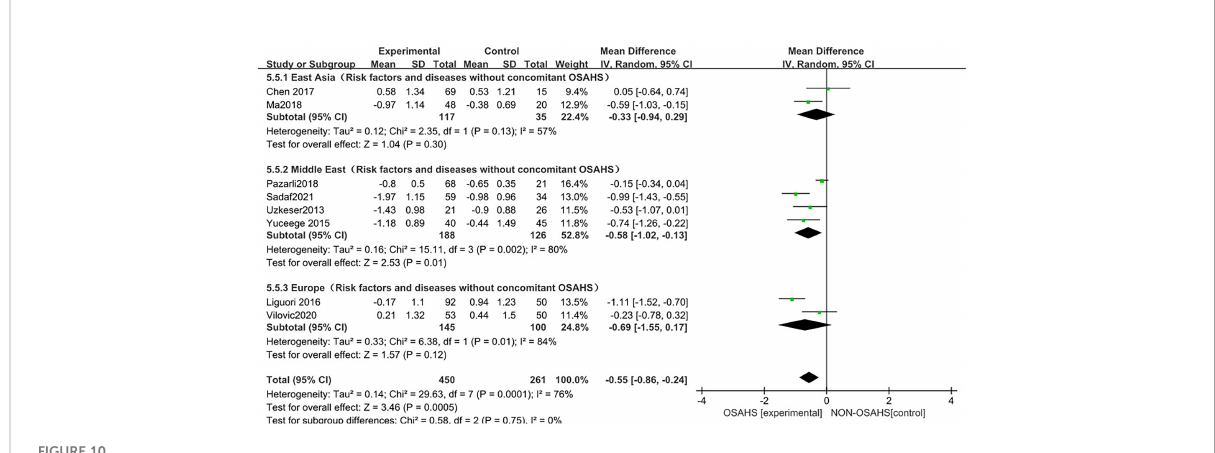
FIGURE 10 Forest plot of lumbar spine T-score “ regional grouping ” subgroup analysis between OSAHS group and control group (after excluding osteoporosis-related risk